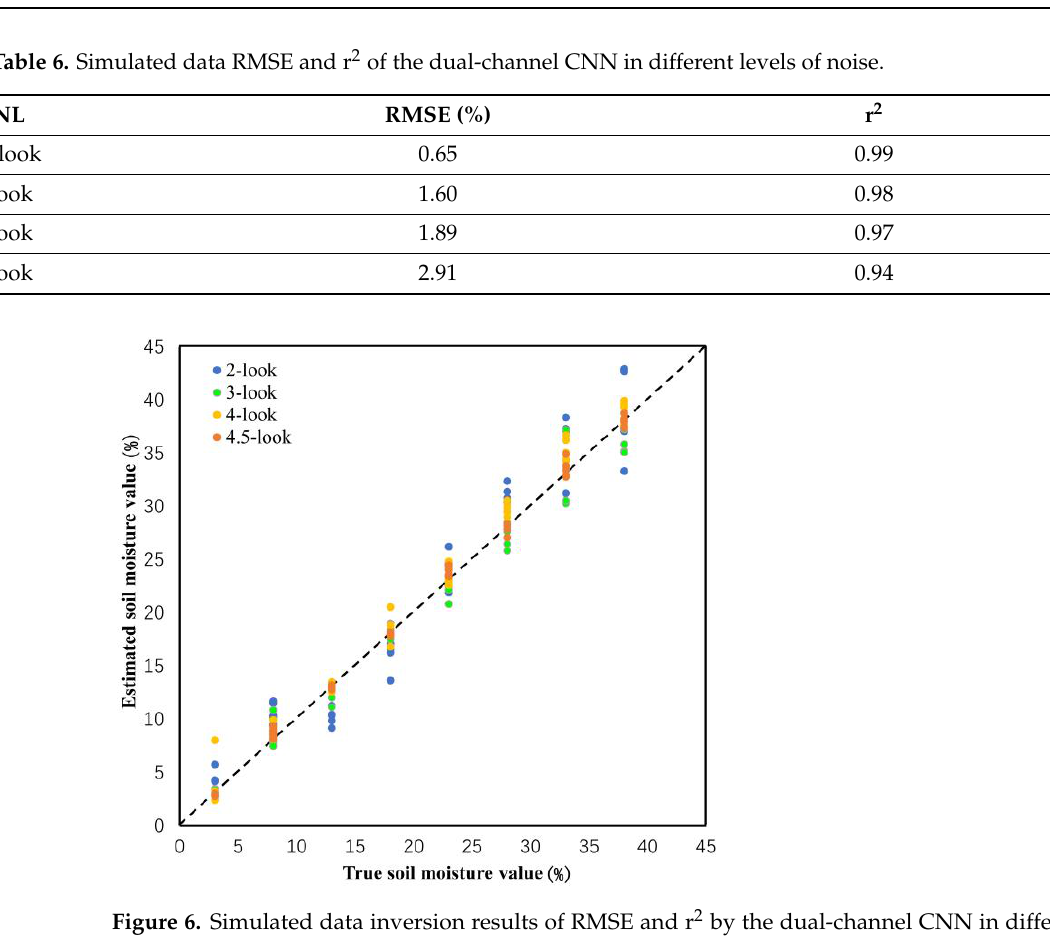
Figure 6. Simulated data inversion results of RMSE and r 2 by the dual-channel CNN in different levels of noise.